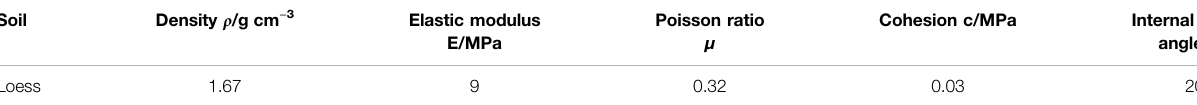
TABLE 1 | Basic physical and mechanical properties of the loess.